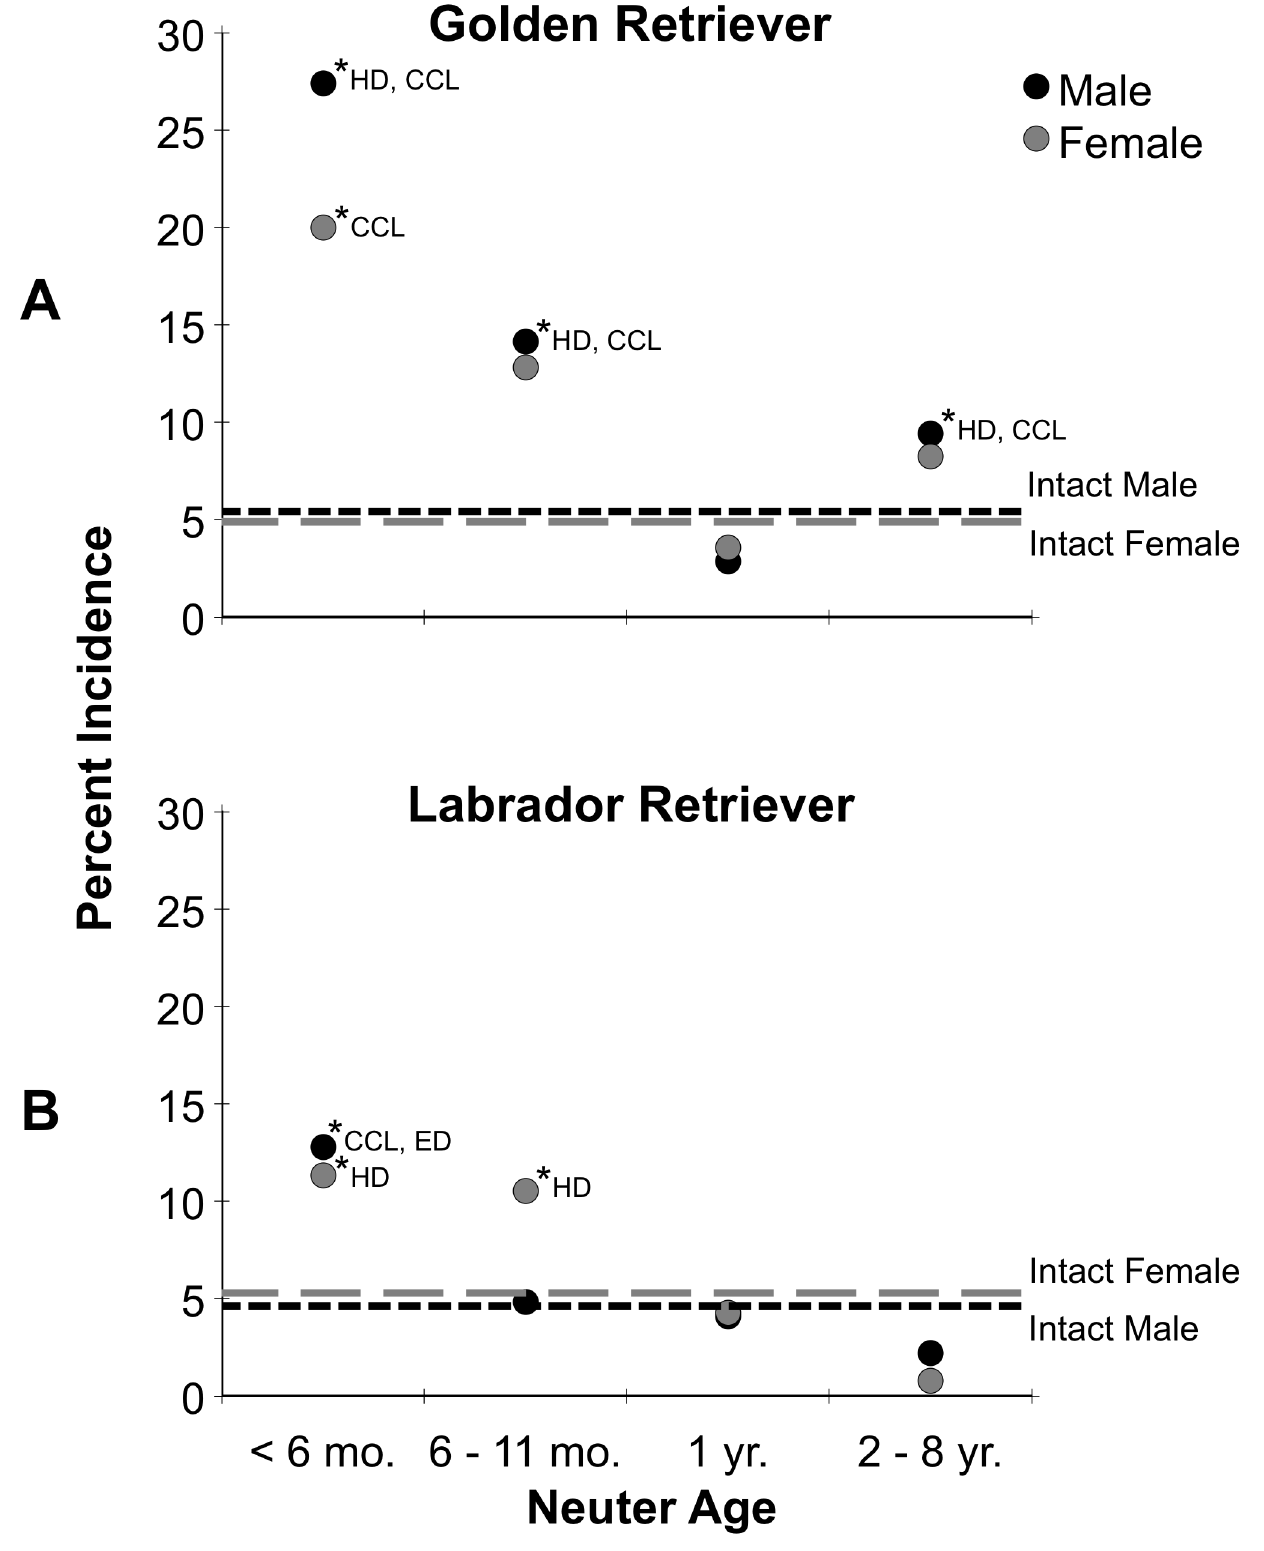
Figure 1. Incidence of the occurrence of at least one joint disorder in male and female Golden Retrievers (top) and Labrador Retrievers (bottom), as a function of age at neutering. The occurrences in intact males and females for the same measure are shown by the horizontal lines. The asterisks indicate significance from the intact level, and the abbreviations reveal the joint disorders contributing to the dots when significant.